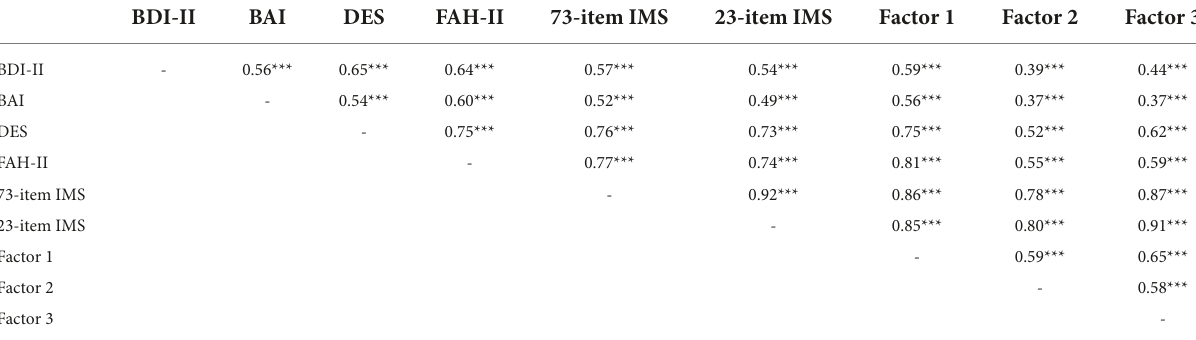
TABLE 3 Pearson’s correlations between the sum scores of used questionnaires measuring depressive symptoms, anxiety symptoms, depressive expectations, and psychological inflexibility as well as the sum score of the constructed 23-item and 73-item questionnaire and the three factors